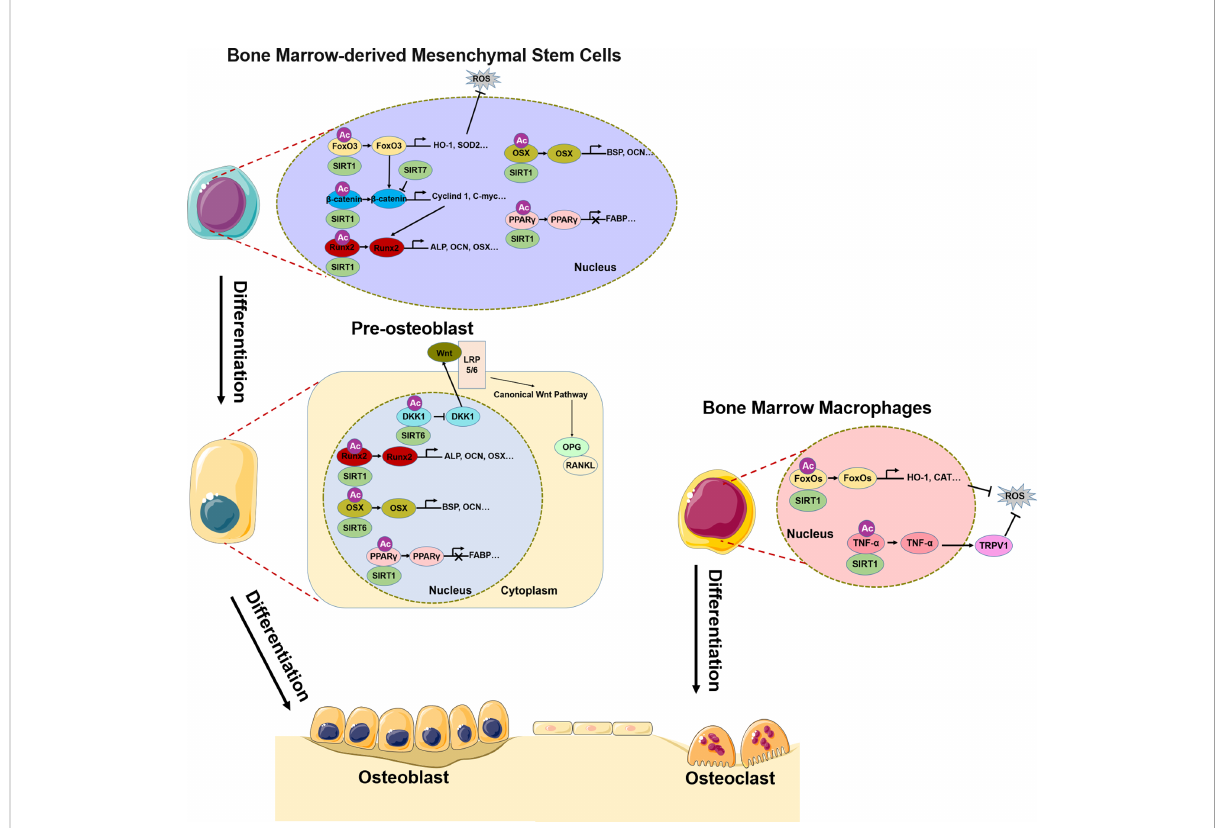
FIGURE 1 Role of SIRT1/6/7 in bone remodeling. In BMSCs, SIRT1, SIRT6, and SIRT7 promote osteogenic differentiation by regulating transcription factors FoxO3 , b -catenin , Runx2 , Osx , and PPAR g . In pre-osteoblasts, SIRT6 not only regulates Runx2 and Osx transcription, but also inhibits DKK1 transcription, activates canonical Wnt signaling, and promotes osteogenic differentiation. In BMMs, SIRT1 inhibits osteoclast differentiation by regulating FoxO and TNF- a transcription, which results in ROS